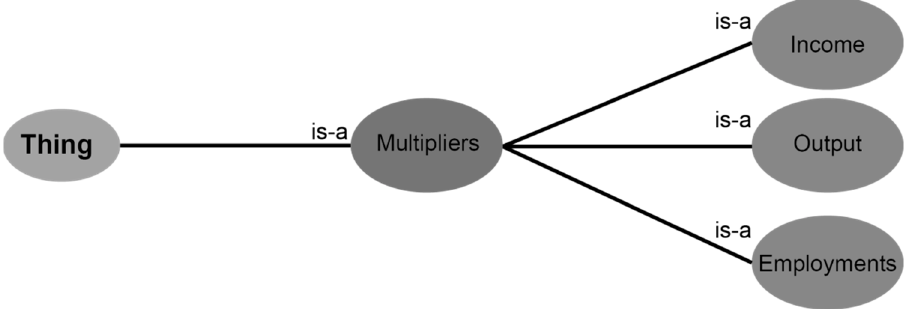
Figure 6. Multiplier concept.